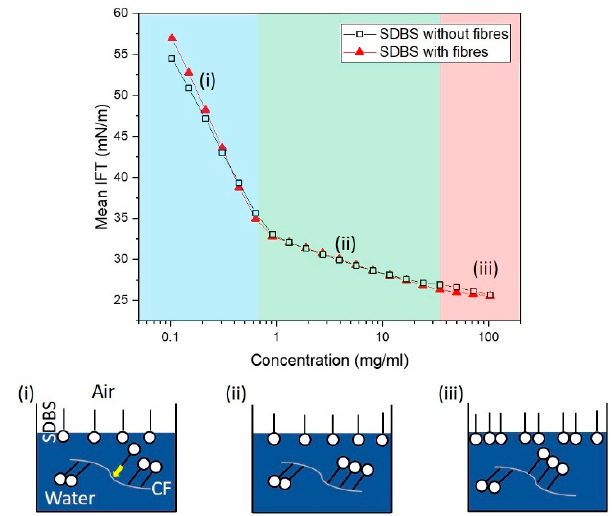
Figure 5. The reduction in the surface tension of the aqueous–air surface with the concentration of SDBS surfactant. The hypothesised adsorption of the SDBS to the fibre is proposed ( i–iii ), where early saturation of the CF is proposed relative to the concentrations tested. (For interpretation of the references to colour in this figure, the reader is referred to the web version of this article).